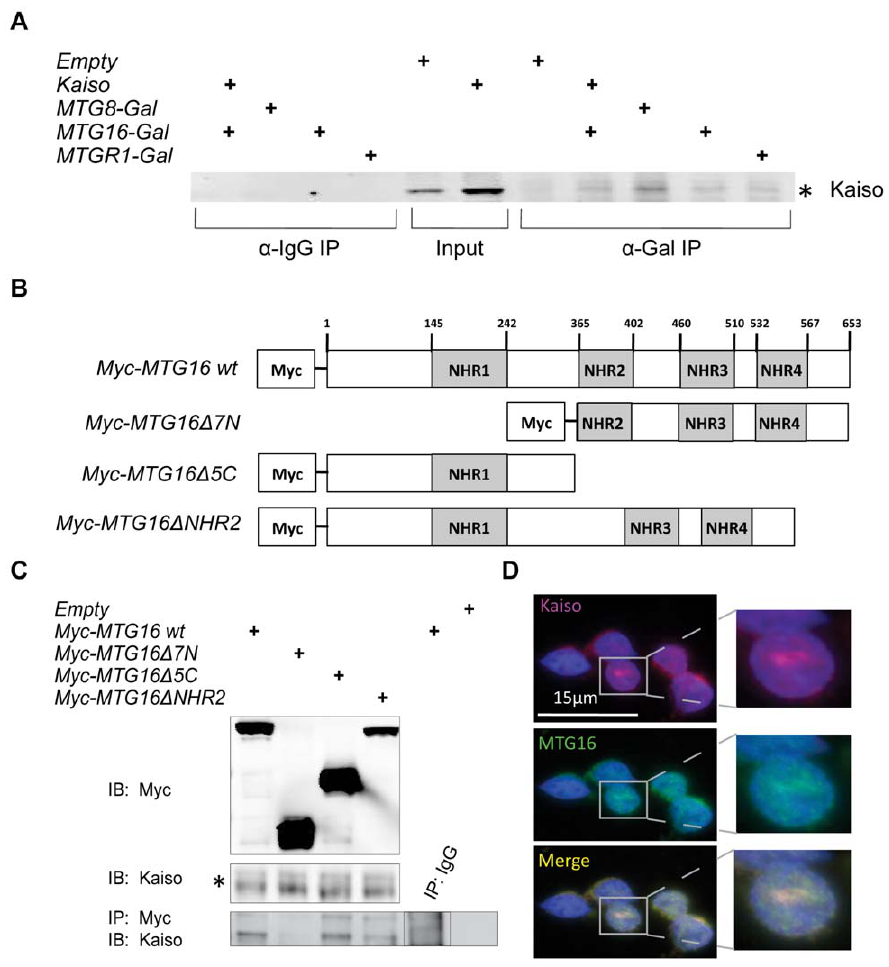
Figure 2. Kaiso and MTG16 associate and co-localize. A. Immunoprecipitation of overexpressed Gal-tagged MTG family members in HCT116 cells. Cell lysates were fractionated and immunoprecipitated with anti-Gal or control IgG and analyzed by immunoblotting with Kaiso antibody. B. Myc-tagged MTG16 constructs used for immunoprecipitation mapping of MTG16 binding site. C. Immunoprecipitation of overexpressed Myc-tagged MTG family members in HCT116 cells. Cell lysates were fractionated and immunoprecipitated with anti-Myc or control IgG and analyzed by immunoblotting with Kaiso antibody. D. K562 cells costained for MTG16 (333, FITC) and Kaiso (polyclonal, ABR, Cy3) were imaged using the Deltavision system, and a correlation coefficient was determined for Kaiso and MTG16 colocalization (r=0.95 6 0.04, n=25 cells).